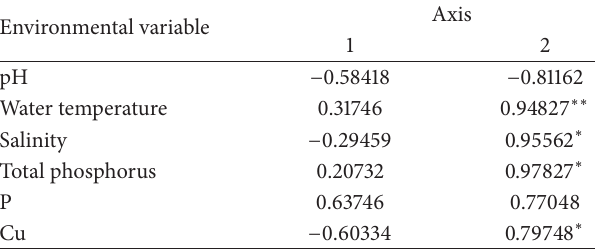
Table 4: Correlation coefficients of environmental variables with the first two axes of canonical correspondence